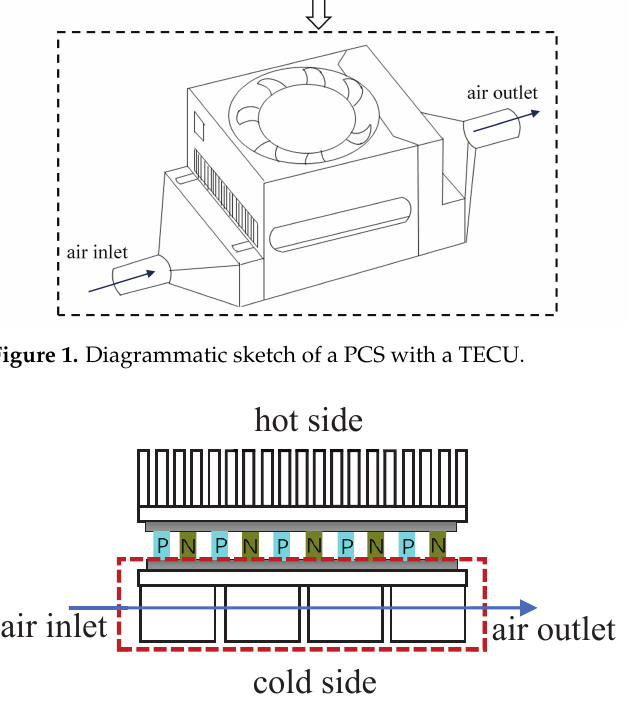
Figure 2. Schematic diagram of a TEM with heat sinks inside the TECU